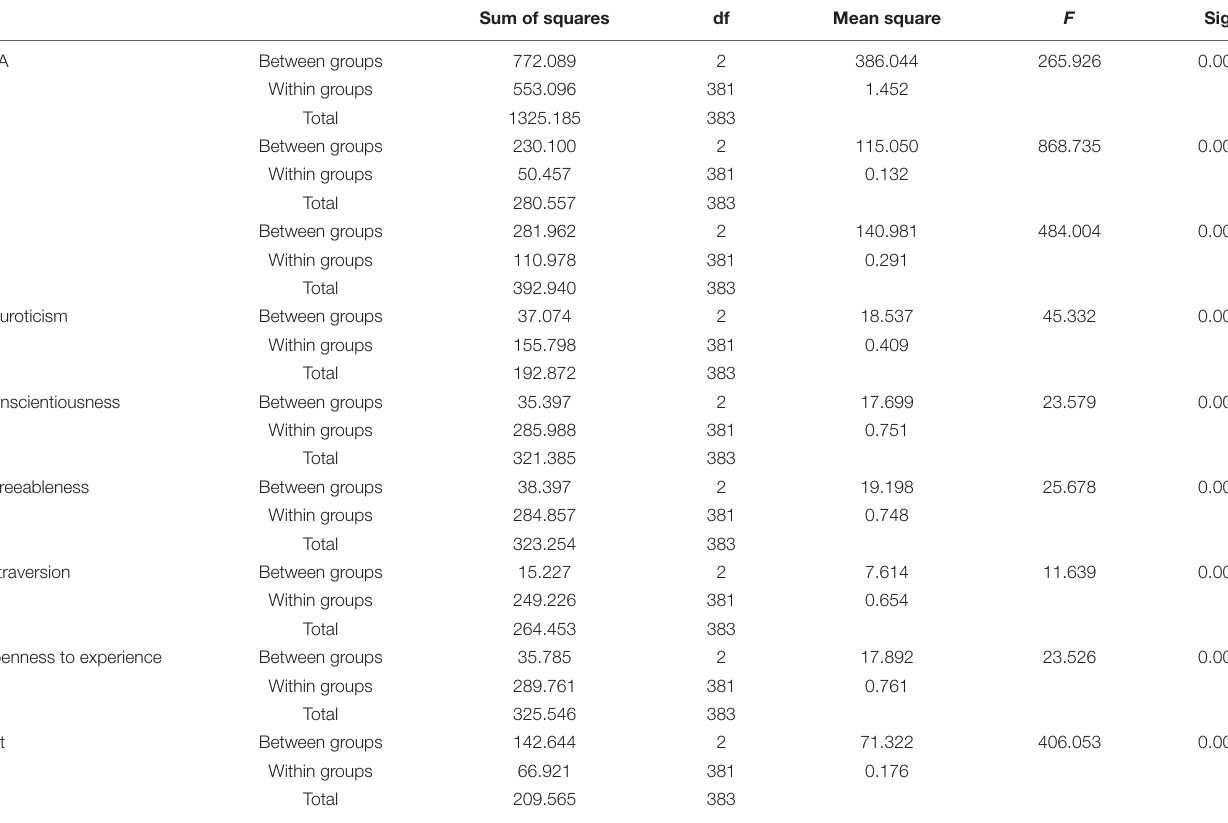
TABLE 4 | Analysis of variance